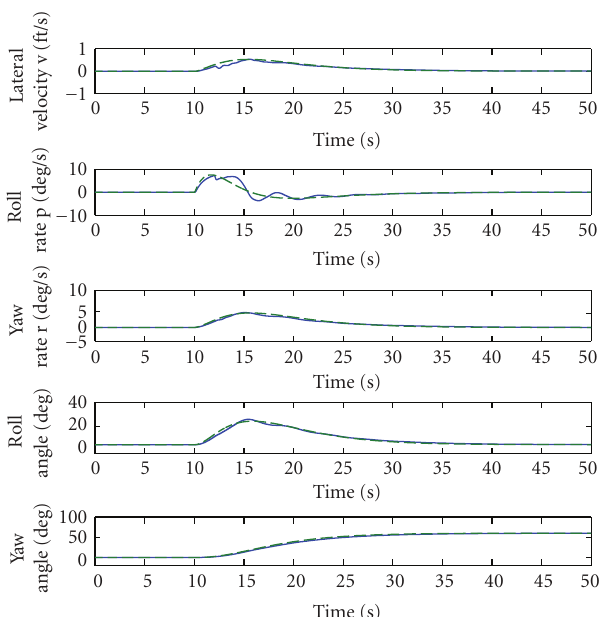
Figure 9: Time history of lateral states (solid) and reference model states (dashed).